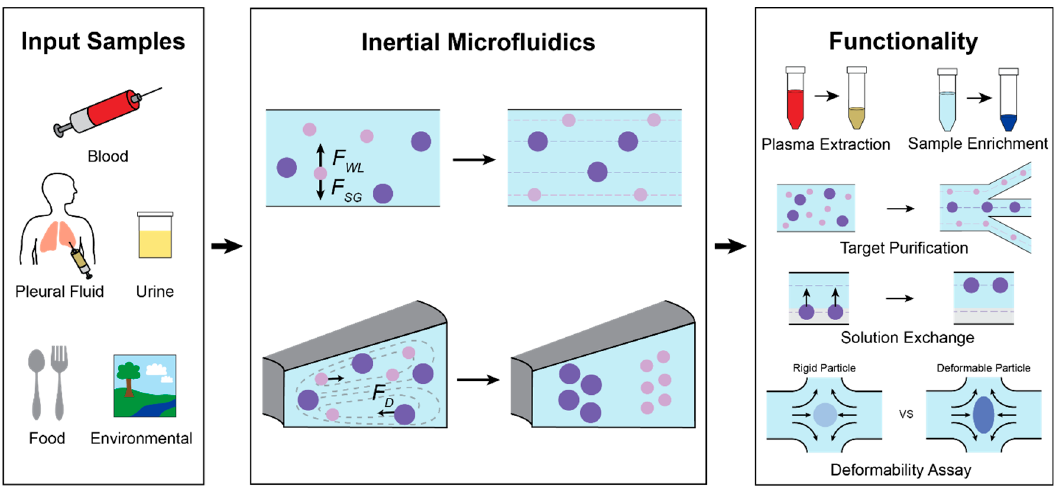
Figure 1. Depiction of concept and analytical capabilities of inertial